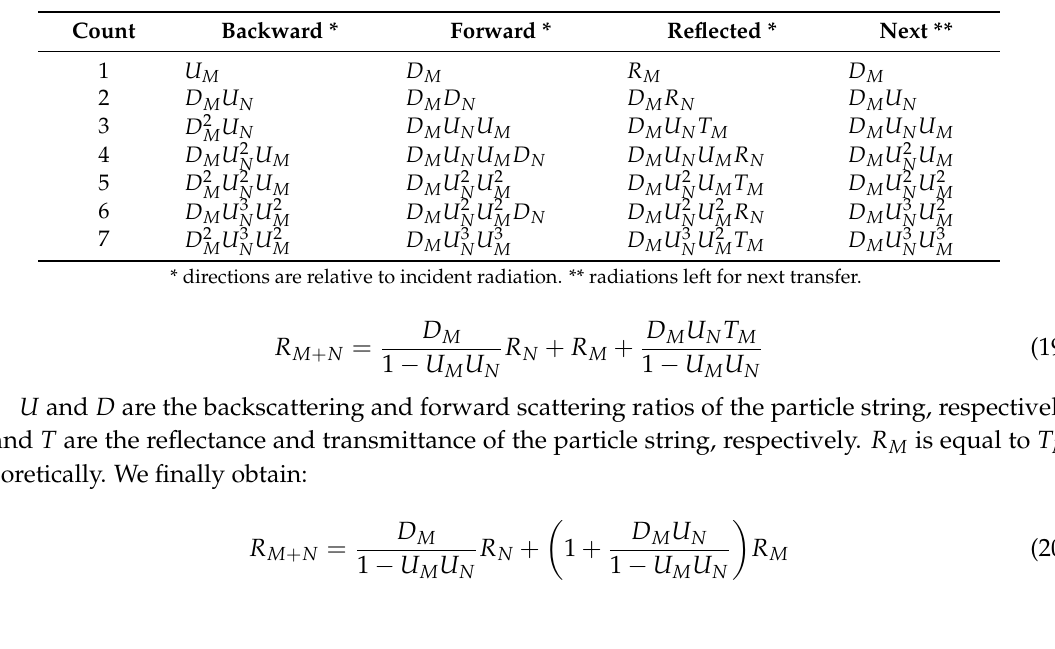
Table 1. Statistics of three directional fractions of outgoing radiation in the n th radiation transfer in Figure 7b. U and D are the backscattering and forward scattering ratios of the particle string, respectively. R and T are the reflectance and transmittance of the particle string,